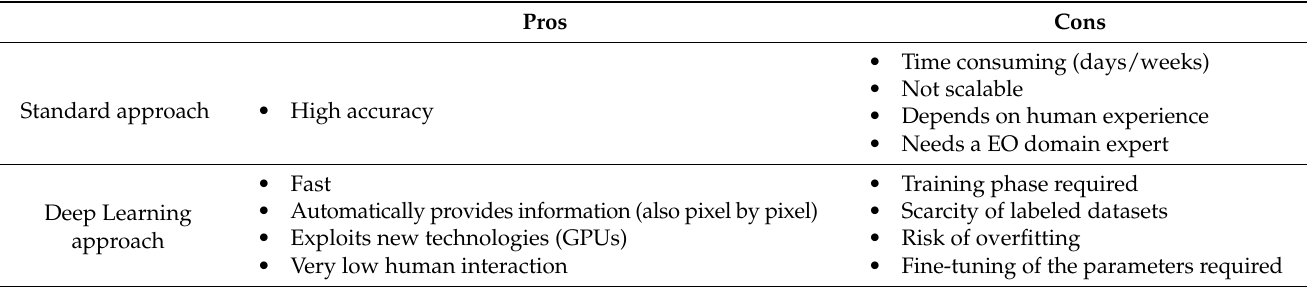
Table 5. Pros and cons of two different approaches to change detection with the Rome-Fiumicino Airport dataset.